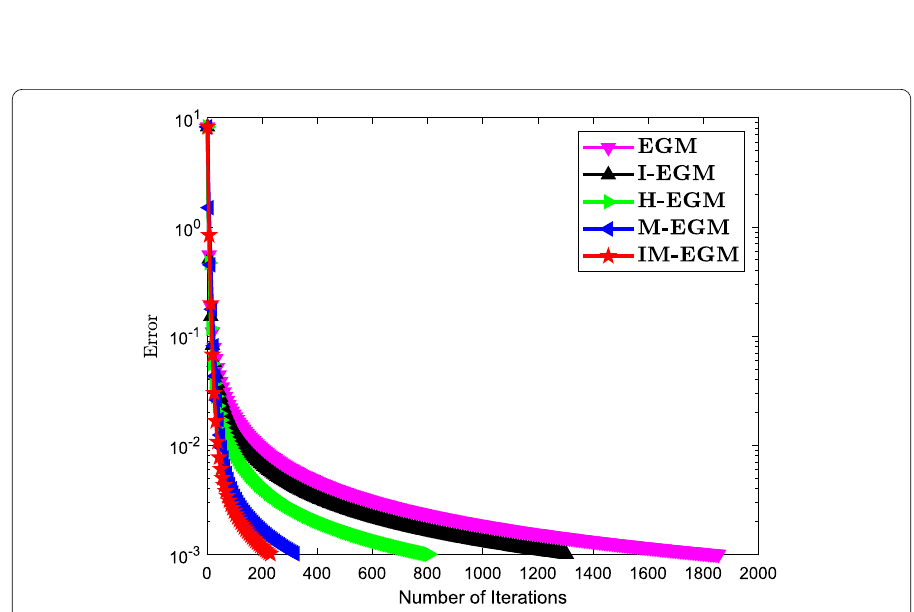
Figure 7 Numerical comparison of Algorithm 1 and Algorithm 2 using Algorithm 1 in [52], Algorithm 2 in [51], and Algorithm 1 in [18], while N = 40 for the error term 10 –3